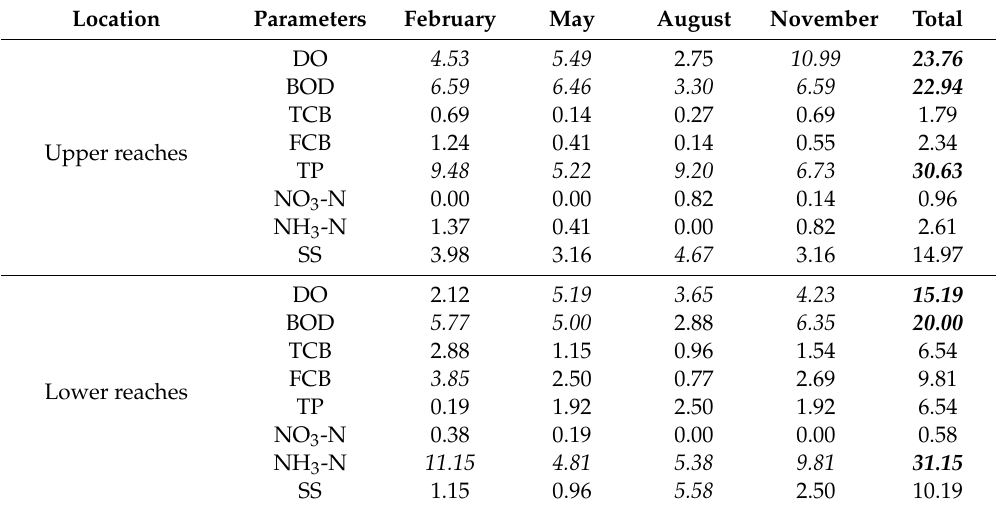
Table 3. Occurrence (in percentage) of eight parameters with the lowest value of the eight scores corresponding to each water monitoring month during the last two decades